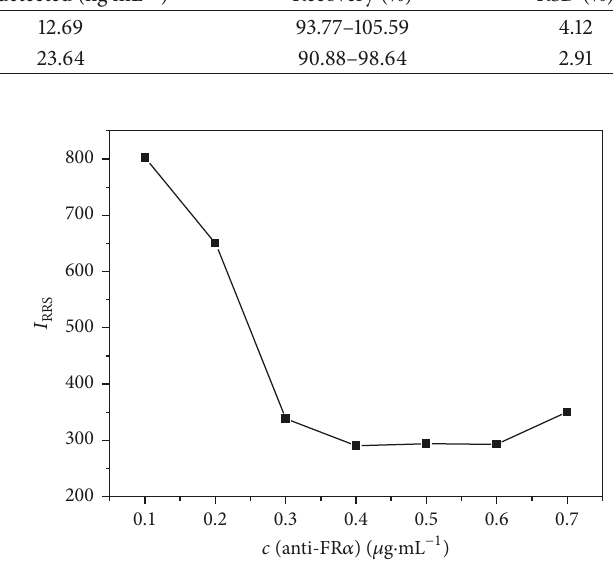
Figure 3: Effect of pH condition on the modification of Au NPs with anti-FR 𝛼 antibody. Concentrations: Au NPs, 3.0 nM; anti-FR 𝛼 , 0.50 𝜇 g ⋅ mL −1 ; NaCl, 0.67%; pH, 1.98, 2.87, 4.10, 5.02, 6.09, 7.00, 7.96, 8.95, 9.91, 10.88, and 11.92.